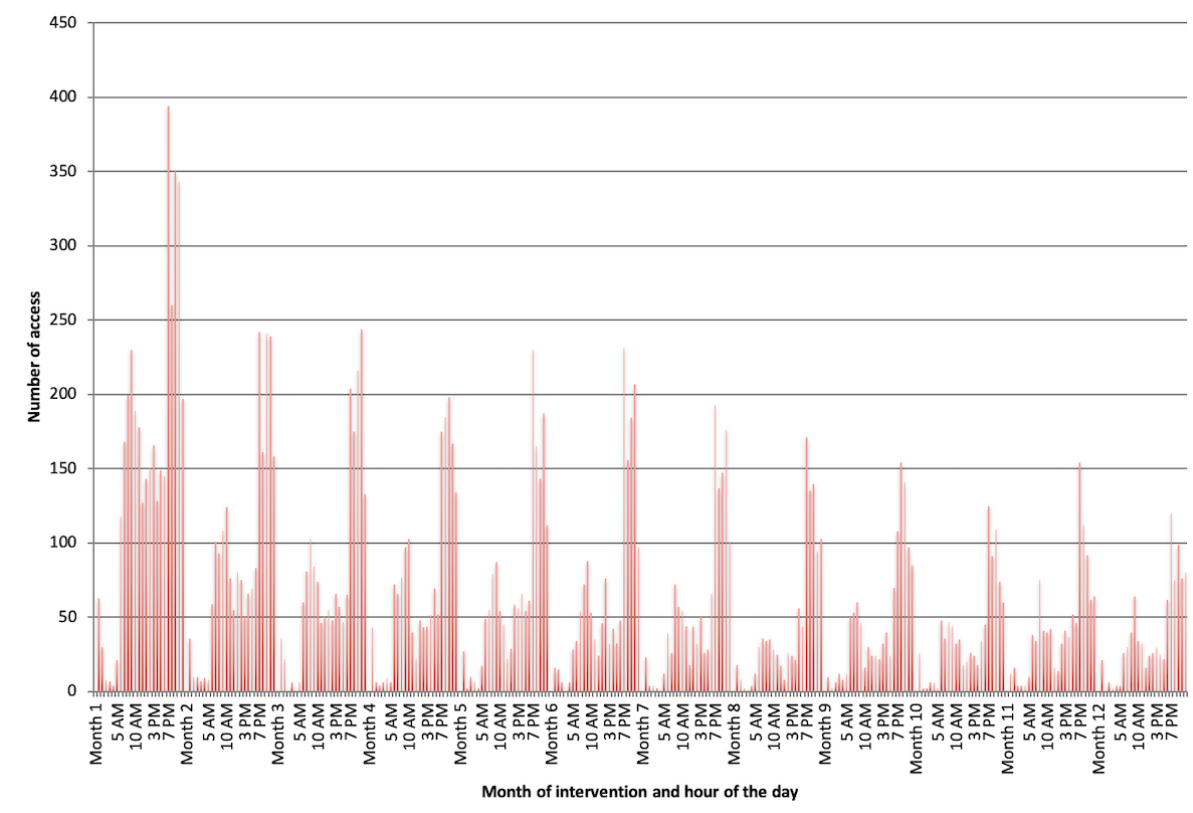
Figure 6. Sustained effect of email reminders on app use over the 12 months of